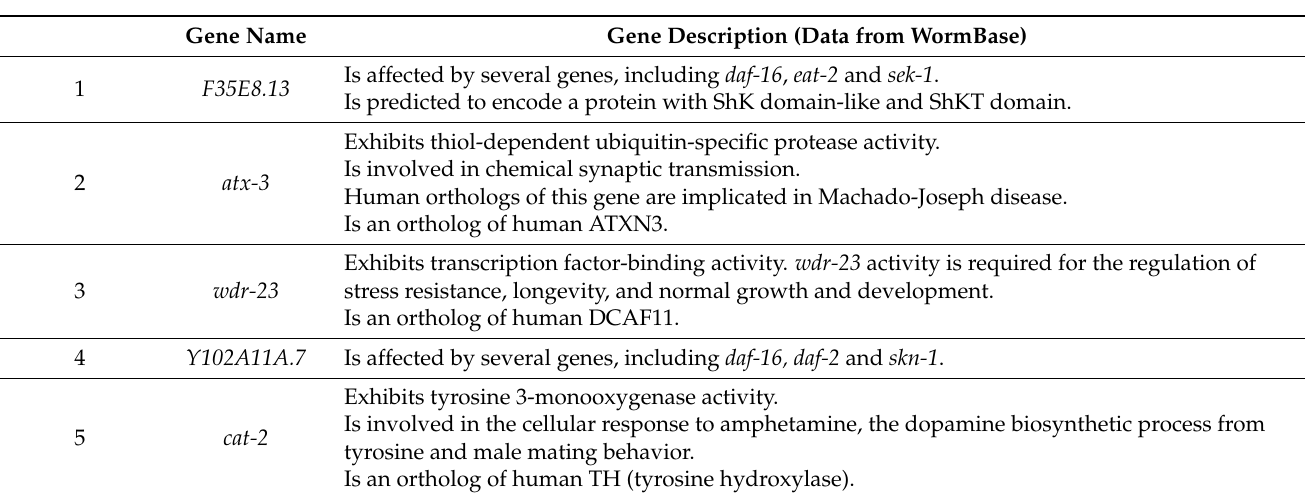
Table 2. Top 5 genes downregulated in response to